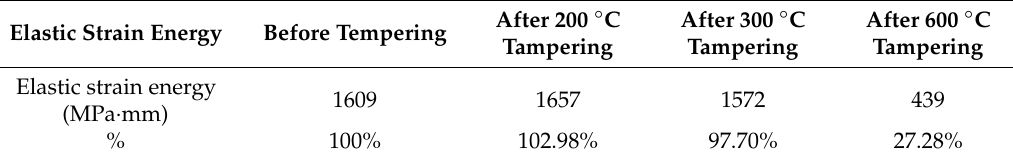
Table 3. Elastic strain energy of residual stress at di ff erent tempering temperatures.